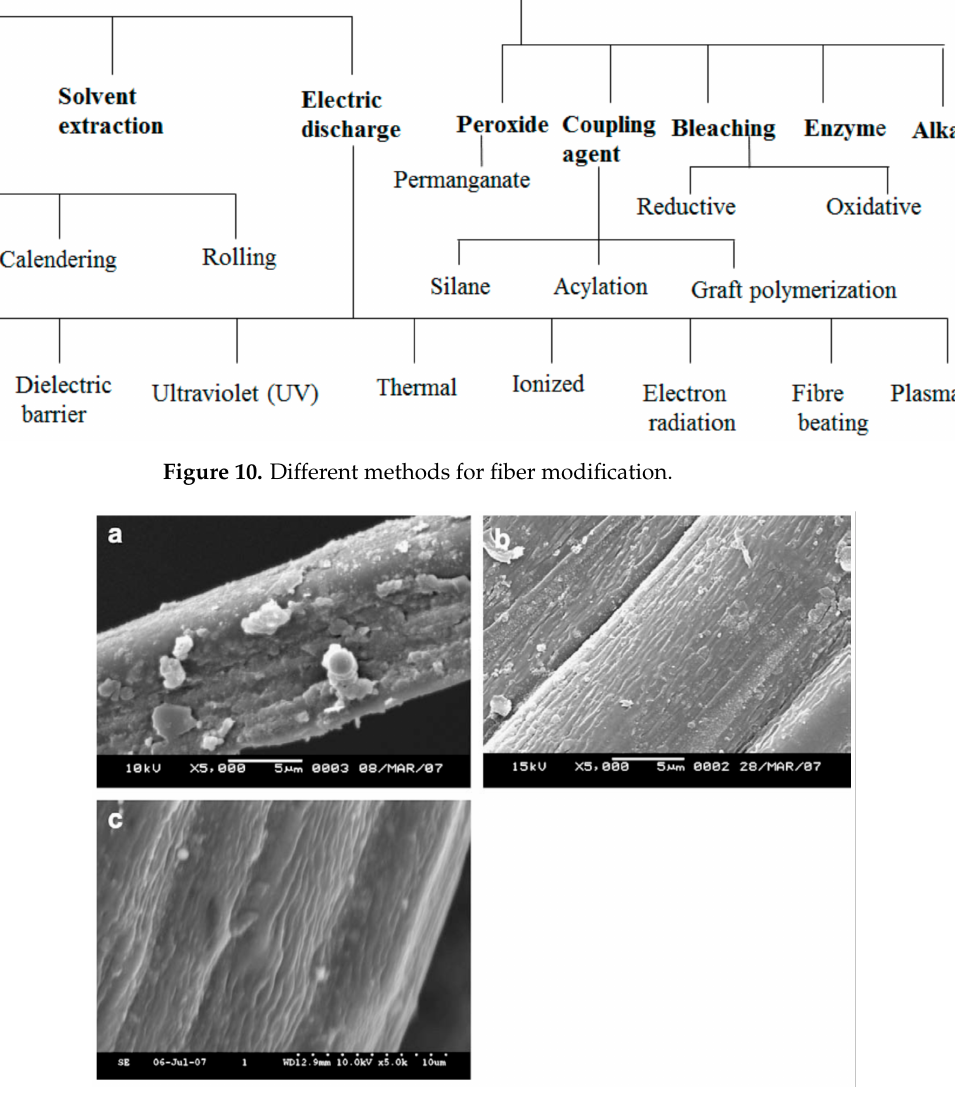
Figure 11. Surface modification of the fiber: ( a ) no modification, ( b ) alkali, and ( c ) coupling treatments. Reprinted with permission from Elsevier